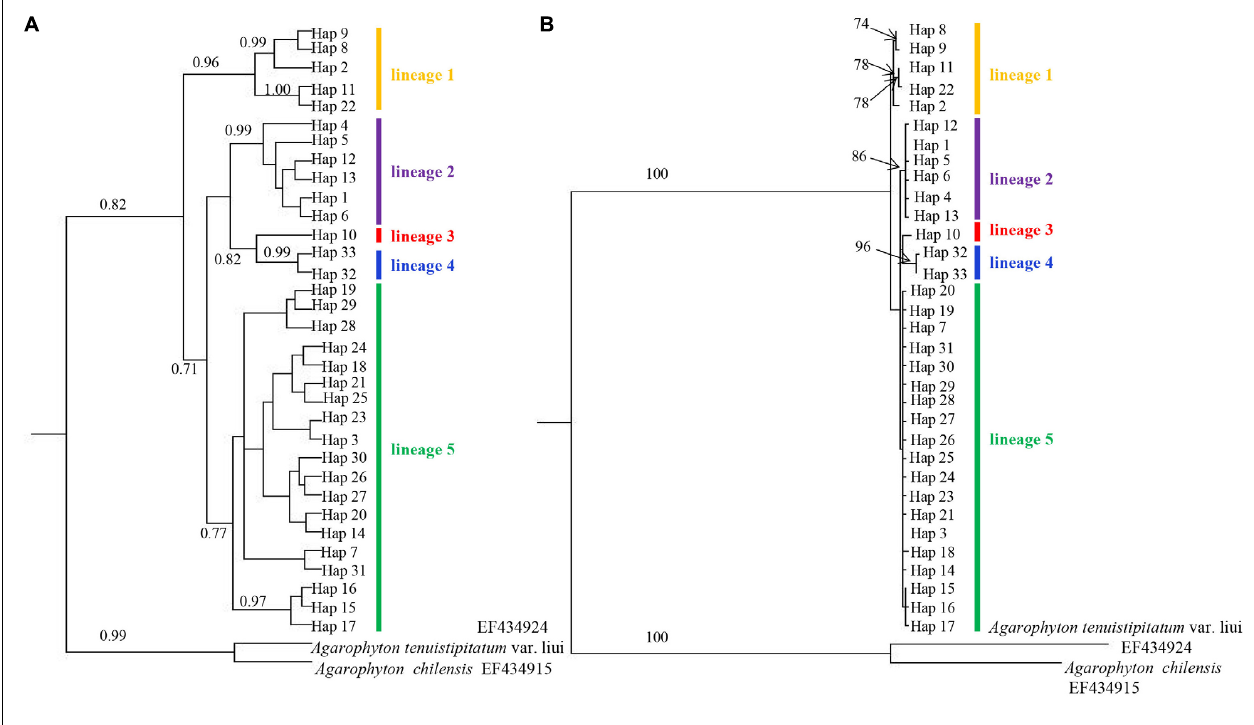
FIGURE 2 | Bayesian inference (BI) tree (A) and maximum likelihood tree (ML) (B) of Agarophyton vermiculophyllum in the northwest Pacific inferred from mitochondrial DNA (mtDNA) c ox 1. Numbers near branches are posterior probabilities (BI) and bootstrap percentages (ML). Values < 0.5 or < 50 not